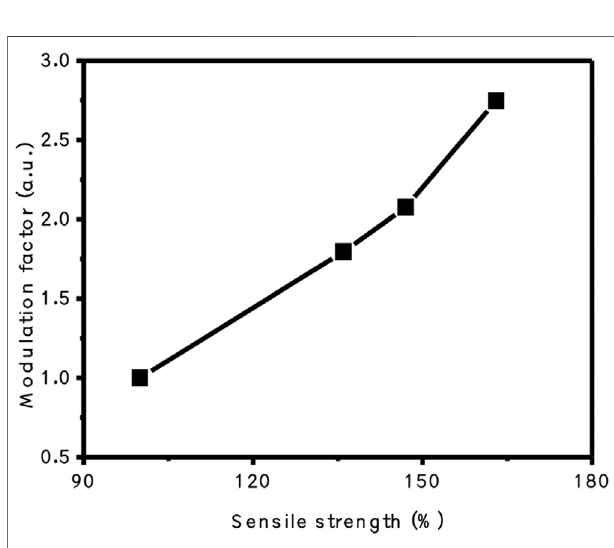
FIGURE 4 | Modulation factor (MF) of samples versus different tensile